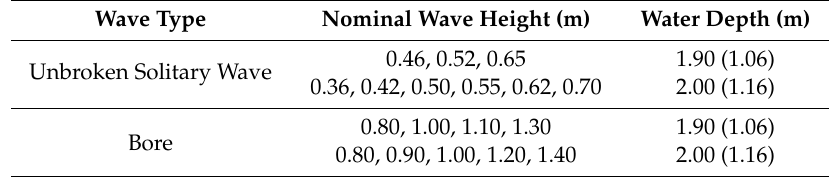
Table 1. Wave matrix used in the experimental testing of the bridge with elastomeric bearings.